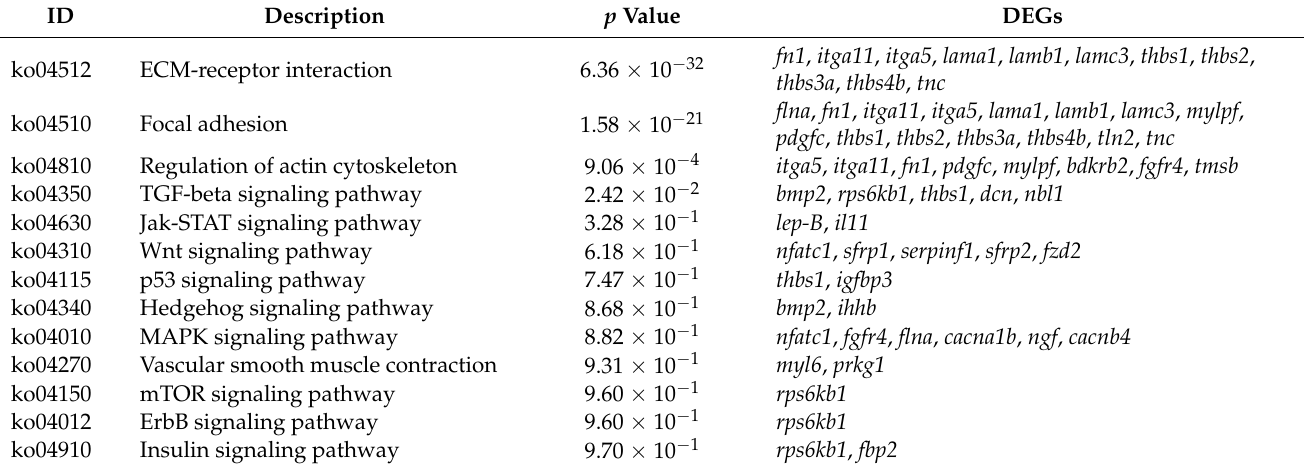
Figure 6. Expression performances of differentially expressed vascularization-related genes in comparisons of RS/OS pertain to loach and yellow catfish. RS: regenerated skins; OS: original skins. Table 2. Key pathways associated with cutaneous air-breathing formation in